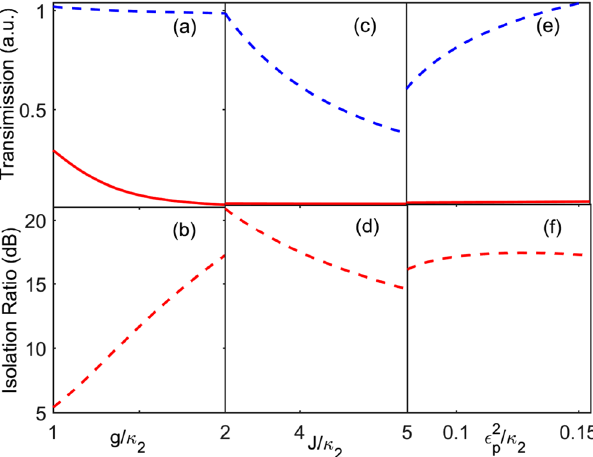
Figure 3. The dependence of nonreciprocal behaviour on some parameters. For the resonant case, the transmission coefficient T R (red solid line) and T L (blue dashed line), and the isolation ratio (red dashed line) varies under the different values of ( a , b ) the cavity-quantum emitter coupling strength g / κ 2 with J = 3.8 κ 2 , and ε κ = . 0 3573 ; ( c , d ) the cavity-cavity coupling strength J / κ 2 with ε κ = . 0 3573 p 2 2 input field ε κ / with g = 2 κ 2 , and J = 3.8 κ 2 . The other system parameters are chosen as γ = 0.17 κ 2 , κ 1 = − 7.4 κ 2 , p 2 and κ e = 3.2 κ 2 ,